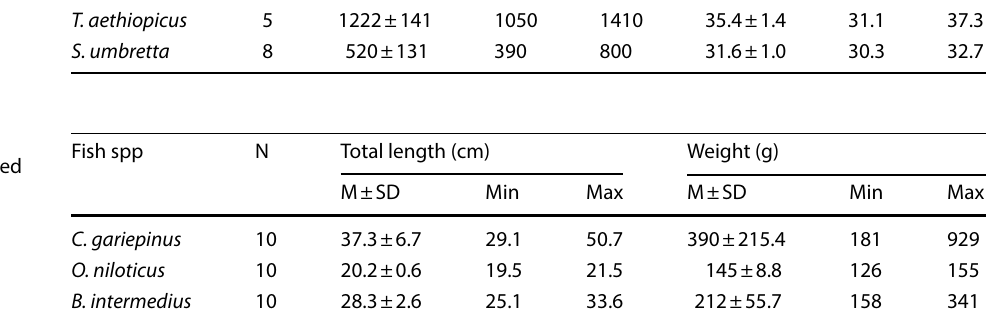
Table 1 Weight and wing chord length of bird species sampled from Lake Hawassa